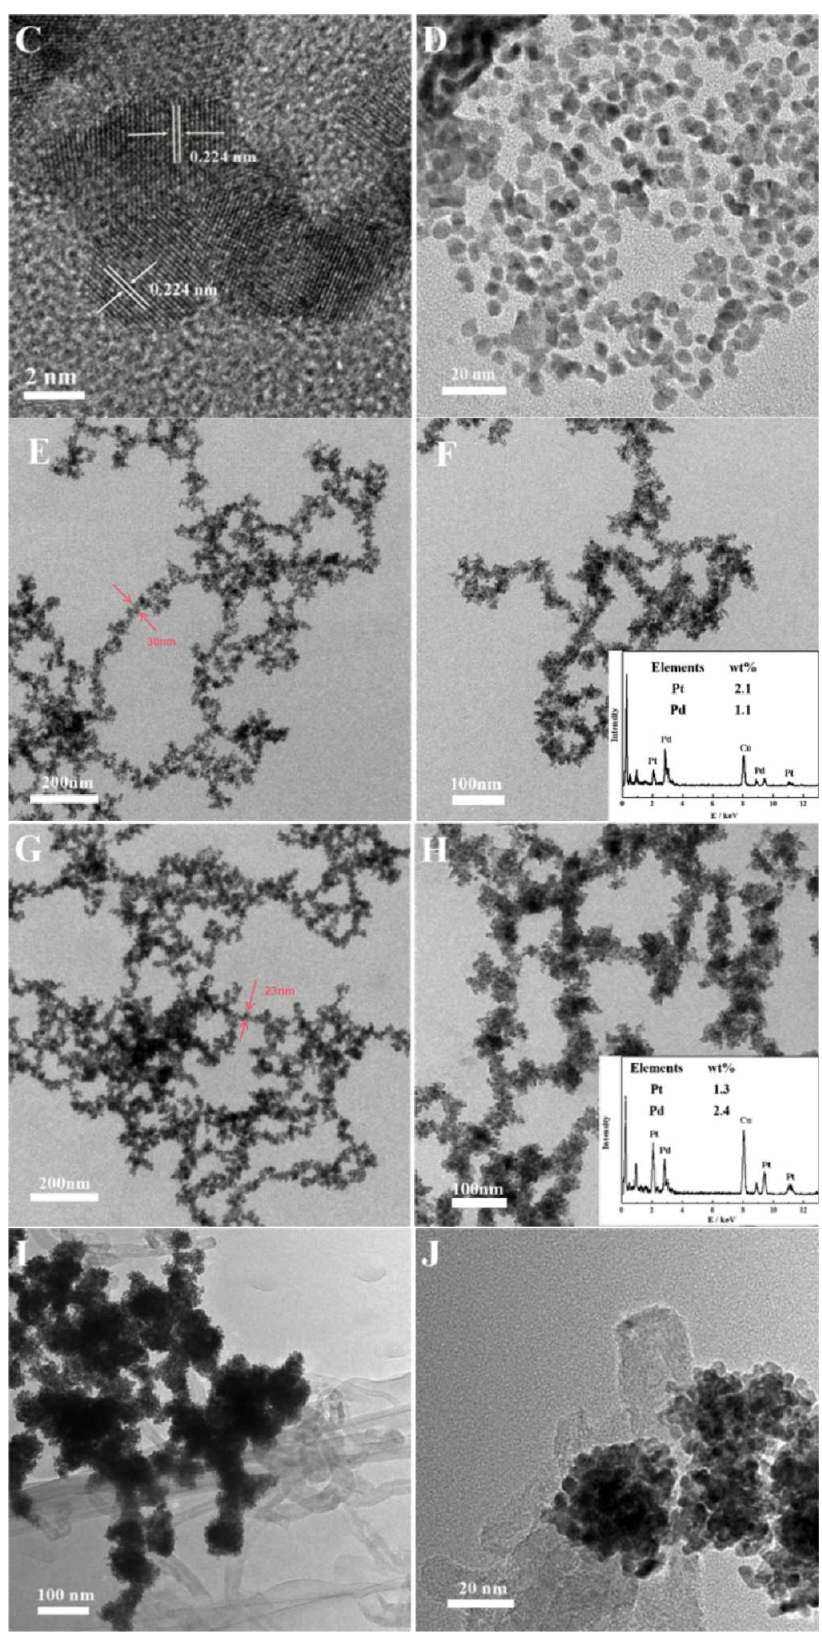
Figure 1. The TEM images and EDS of ( A , B ) Pt 1 Pd 1 NCs, ( C ) the HRTEM image of Pt 1 Pd 1 NCs, ( D )